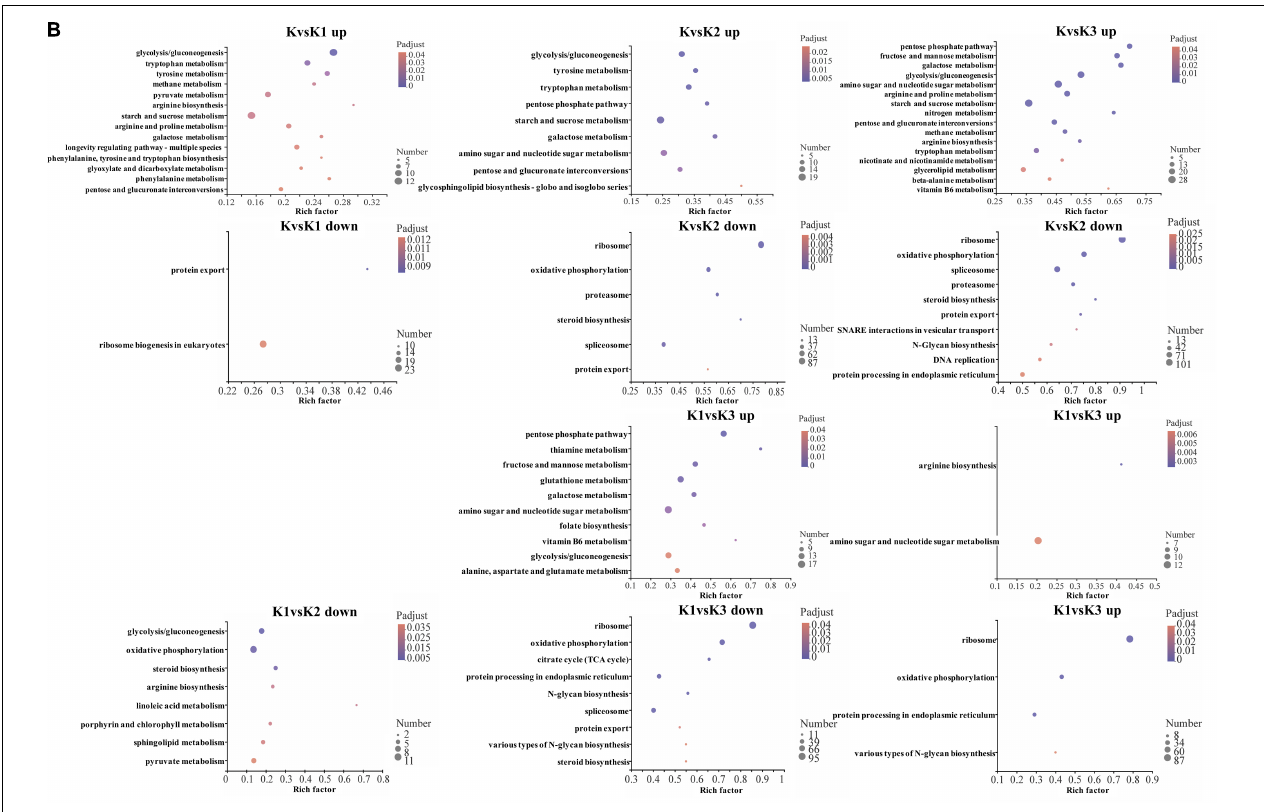
FIGURE 7 | GO enrichment analysis (A) and KEGG enrichment pathway analysis (B) of the differentially expressed genes (DEGs). GO and KEGG enrichment were filtered using the significant criterion of corrected p <